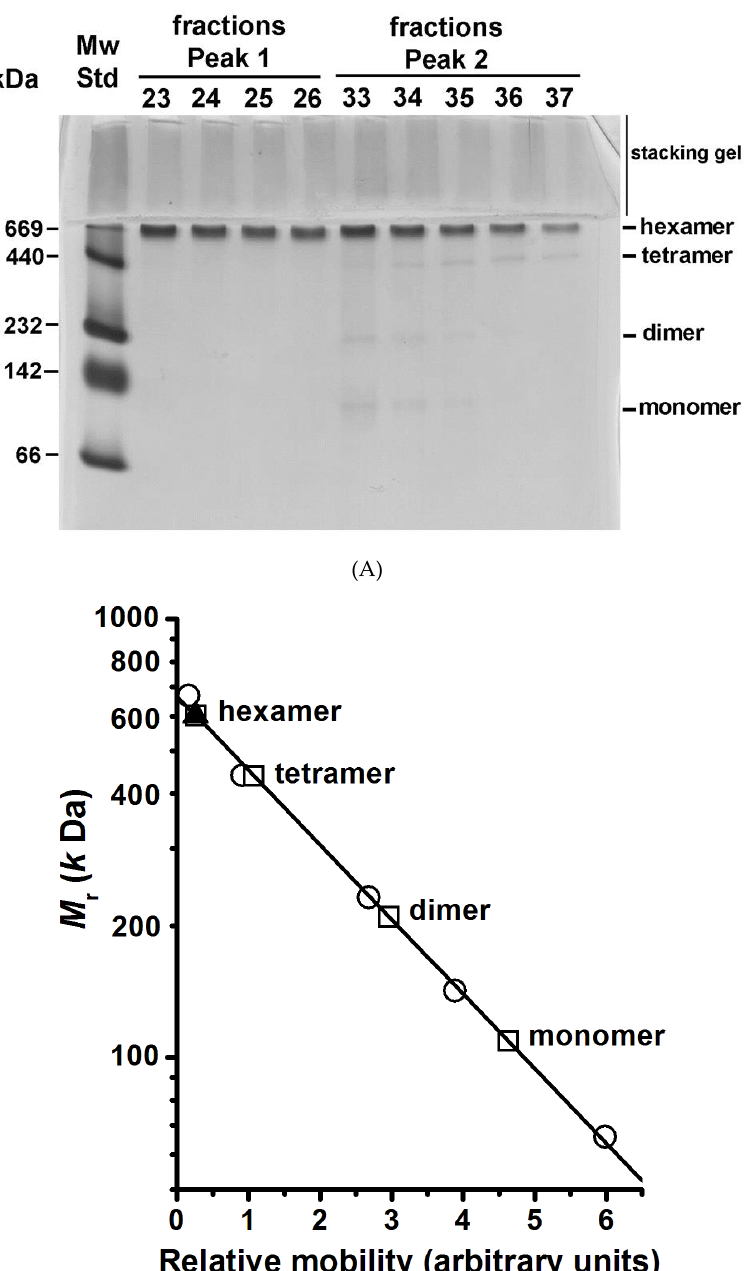
Figure 3. The quaternary structure of the plasma membrane H + -ATPase from K. lactis . ( A ) BN-PAGE of the H + -ATPase oligomers forming the MASs eluted in fractions of Peaks 1 and 2 in the size exclusion chromatography (blue line in Figure 2). The BN-PAGE was performed as described in the methods section, and the gel was silver stained. ( B ) Plot of the H + -ATPase’s relative molecular weight in its different oligomeric states as determined by densitometry analysis using the software ImageJ (https://imagej.nih.gov/ij/): ( ) molecular weight standards (MW std), ( ) H + -ATPase hexamer eluted in chromatographic Fractions 23 – 26 in Peak 1, and ( ) H + -ATPase oligomers eluted in chromatographic Fractions 33 – 37 in Peak 2.